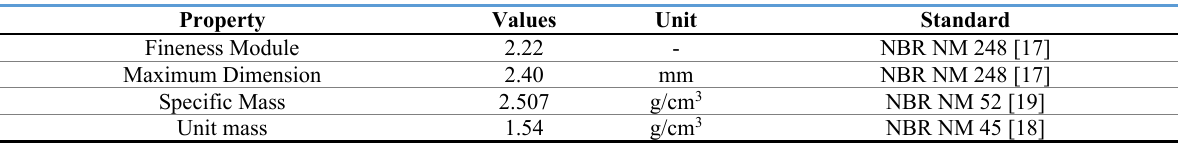
Table 2. Physical properties of the fine